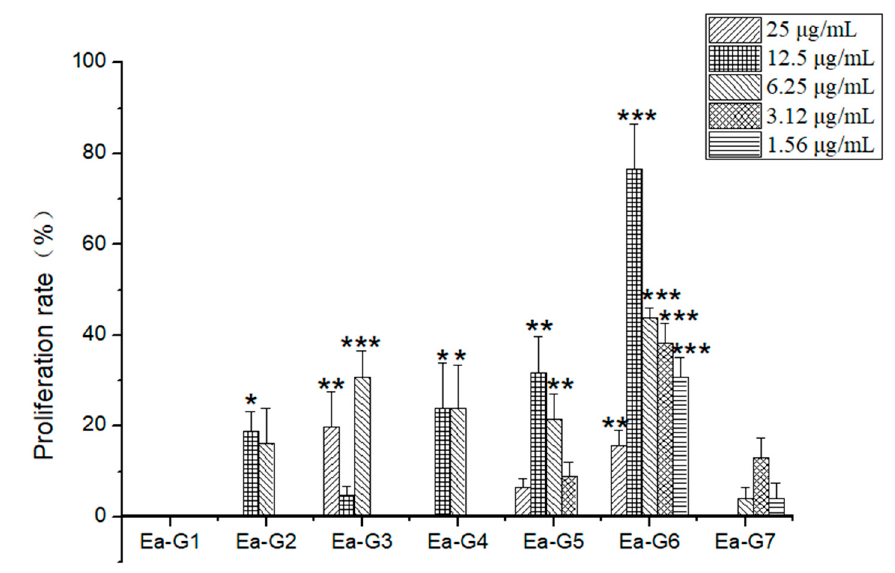
Figure 3. The effect of each fraction in the EA extract to promote the proliferation of NSCs. Different